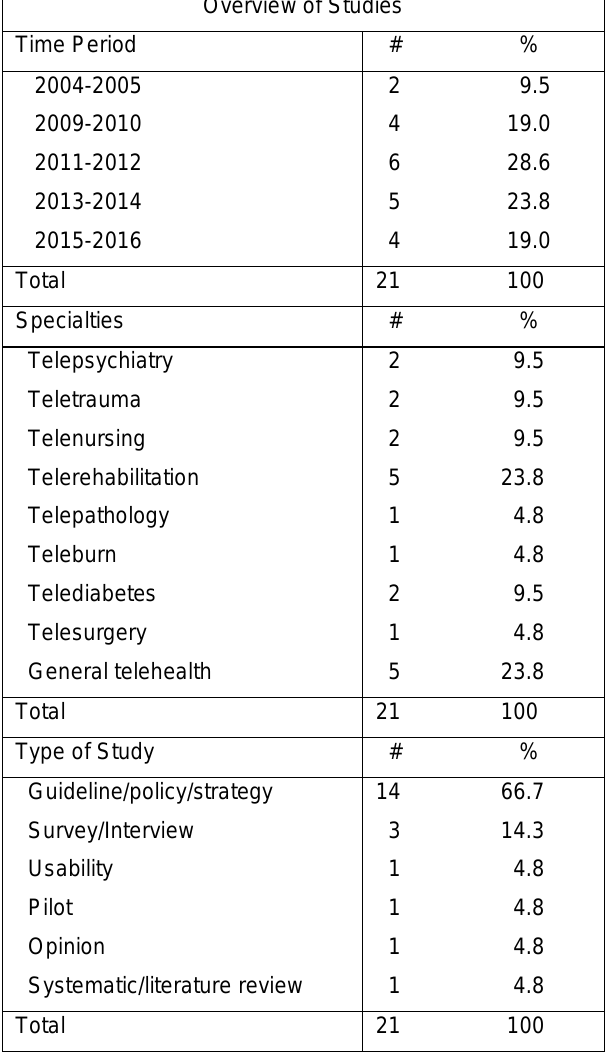
Table 1. Overview of Reviewed